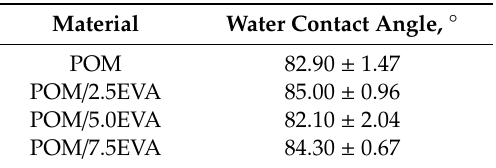
Table 8. Values of contact angle for prepared